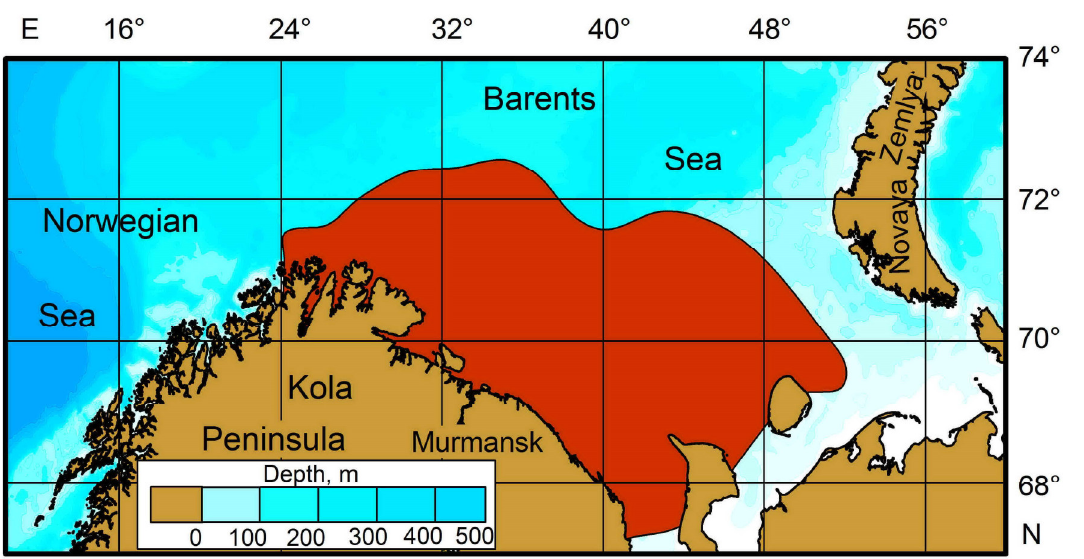
Figure 1. Distribution of red king crabs in the Barents Sea (adapted from [24]).